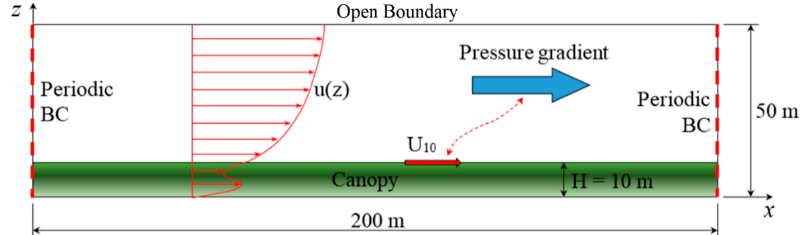
Figure 1. Two-dimensional (2D) view of the computational domain and boundary conditions used for phase 1. Domain width was 50 m in the y -direction with periodic boundary conditions.